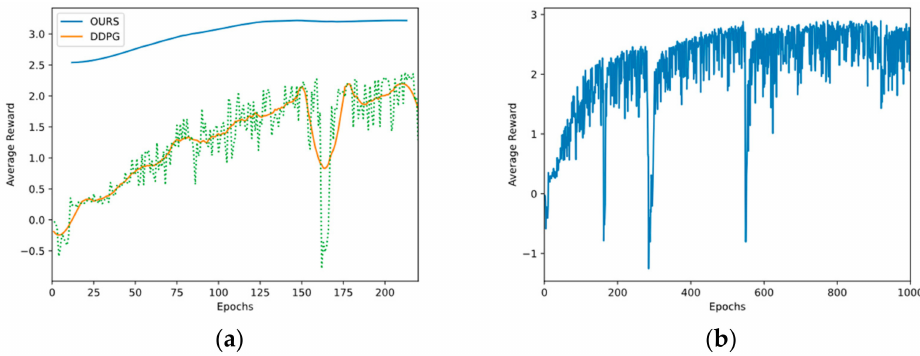
Figure 11. Average reward during robot training. ( a ) Ours vs. DDPG. ( b ) DDPG.